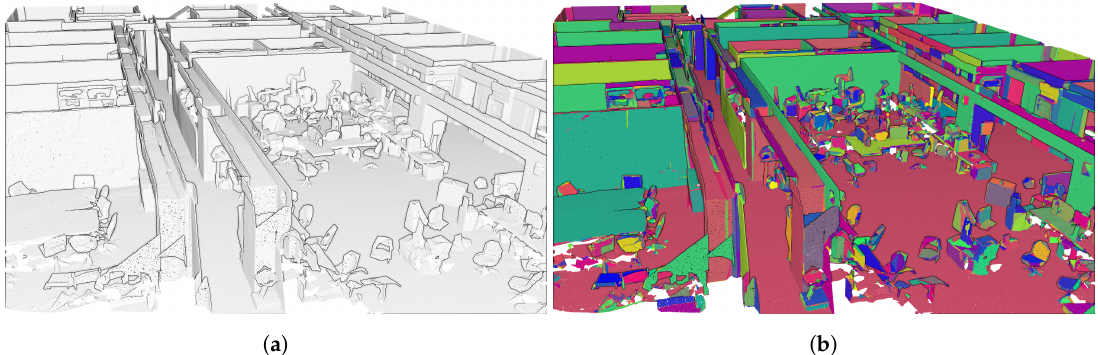
Figure 1. Overview of the planar segments produced by the point cloud and meshing region growing.